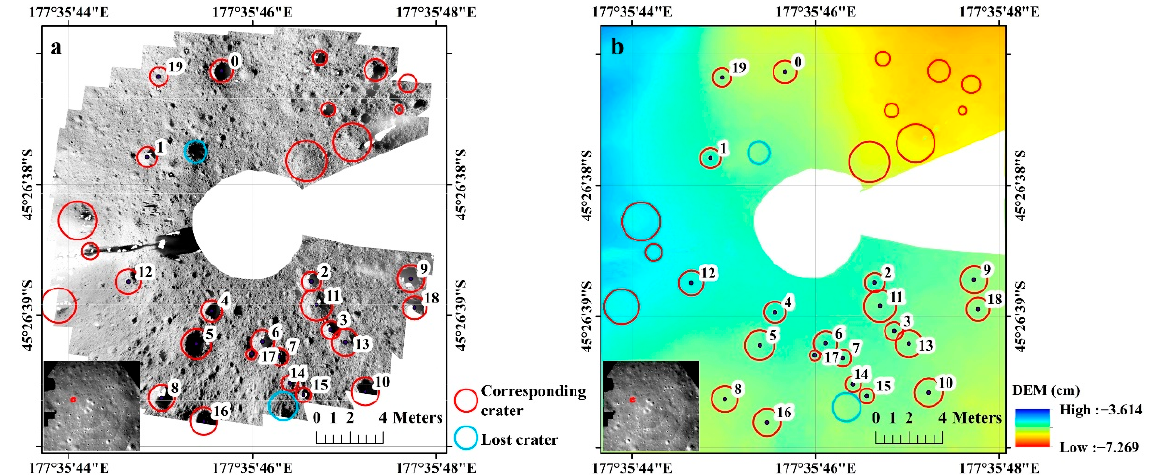
Figure 10. DOM ( a ) and DEM ( b ) of the third lunar day PCAM of Yutu-2, where the red impact craters are the corresponding craters of the PCAM and LCAM, and the blue represents impact craters not identified by the LCAM. The areas shown in ( a , b ) correspond to the red area of the LCAM mosaic image thumbnail in the lower left corner of the figure.